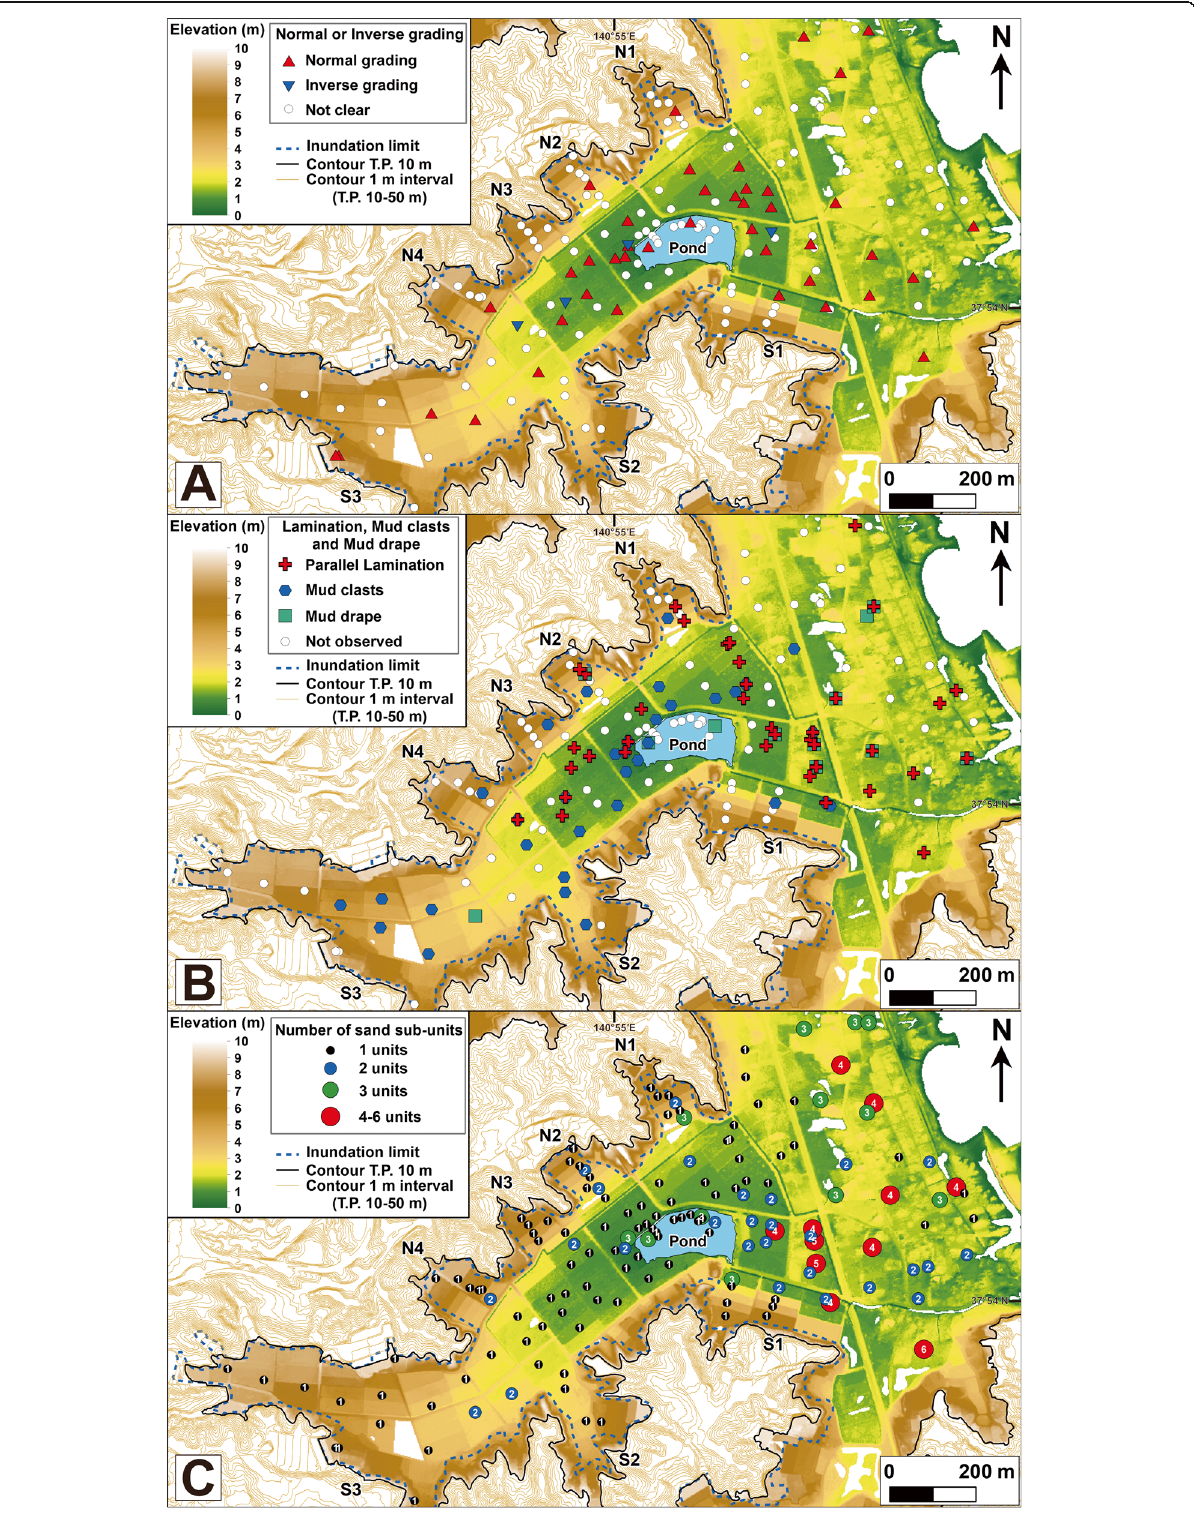
Fig. 6 Spatial distribution of sedimentary structures: a normal grading and inverse grading; b parallel lamination, mud clasts, and mud drape; and c number of sand sub-units. Elevation map and contour line are based on the 2 m grid DEM data provided by